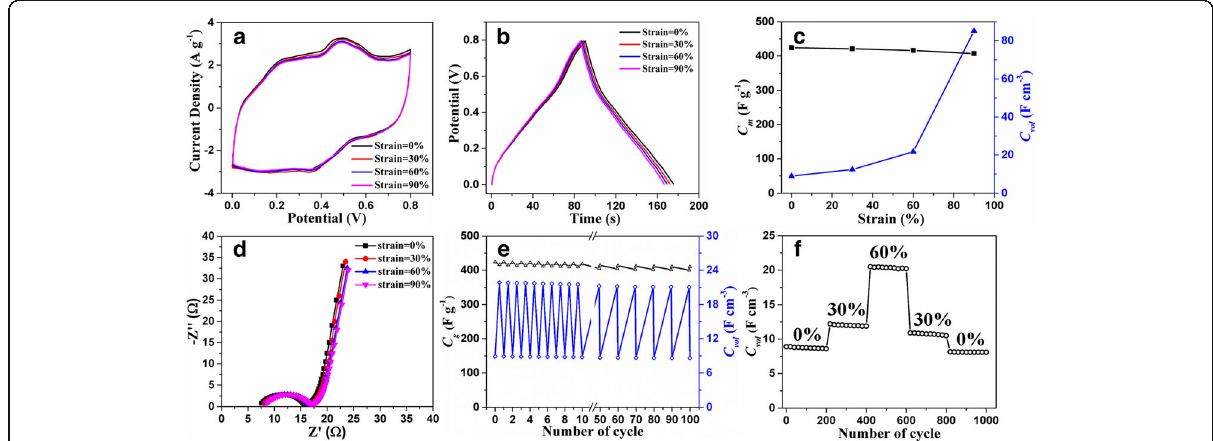
Fig. 7 a CV curves, b GCD curves, c capacitive properties, and d Nyquist impedance plots of the SCs based on graphene/PANI-2 electrodes at various compressive strains, scan rate 20 mV s − 1 , current density 1 A g − 1 . e The variation of gravimetric capacitances and volumetric capacitances of graphene/PANI-2 electrodes at original state then under compressive strain of 60% for each cycle. f Cycle performance test for 1000 charge/ discharge cycles under constant compressive strains of 0, 30 and